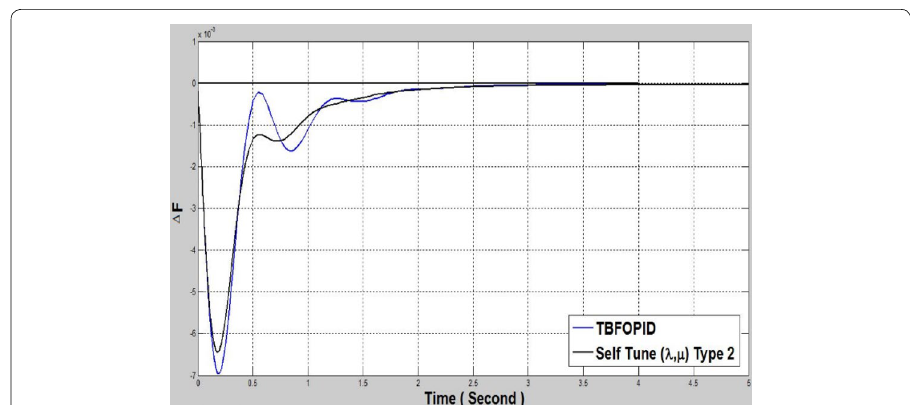
Fig. 22 Response of Δ F via IT2FST ( λ and μ )